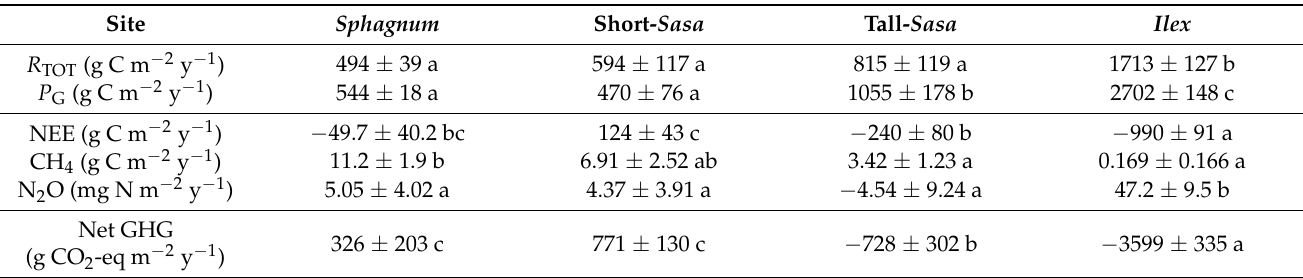
Table 1. Greenhouse gas (GHG) budgets at each vegetation